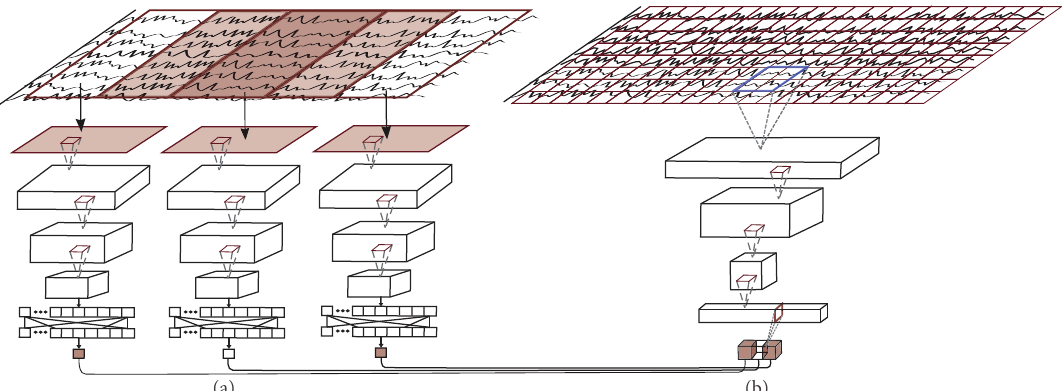
Figure 2: From sliding time window approach to convolutional implementation of the sliding time windows. (a) The EEG data are segmented into three pieces by sliding time windows. These pieces are predicted with class probabilities, respectively. (b) The same EEG data are processed by a pure convolution and obtain directly three output cells which are corresponding to three pieces generated by sliding time window in